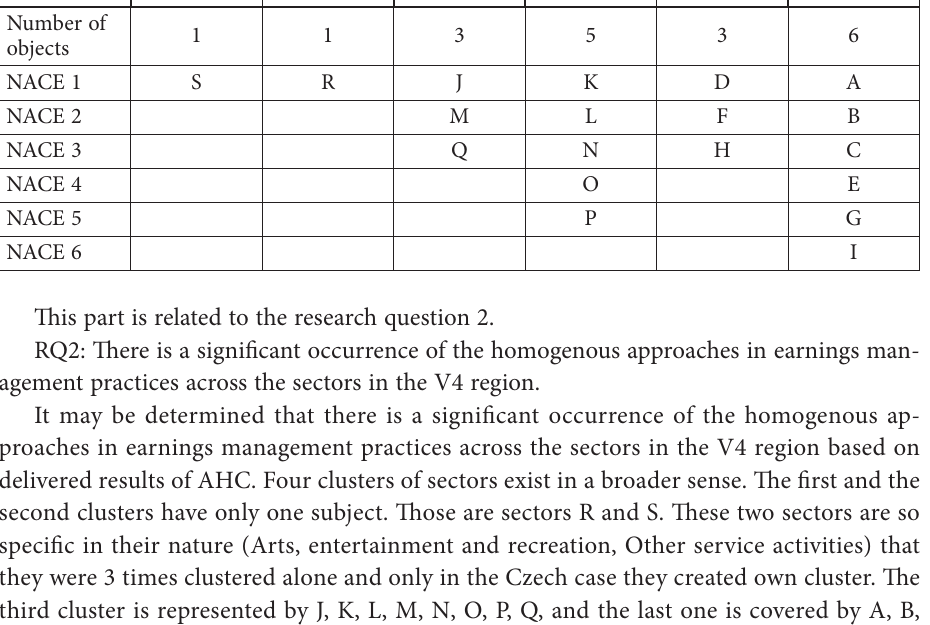
Table 6. Clusters of Poland (source: authors) Cluster C1 C2 C3 C4 C5 C6 Number of